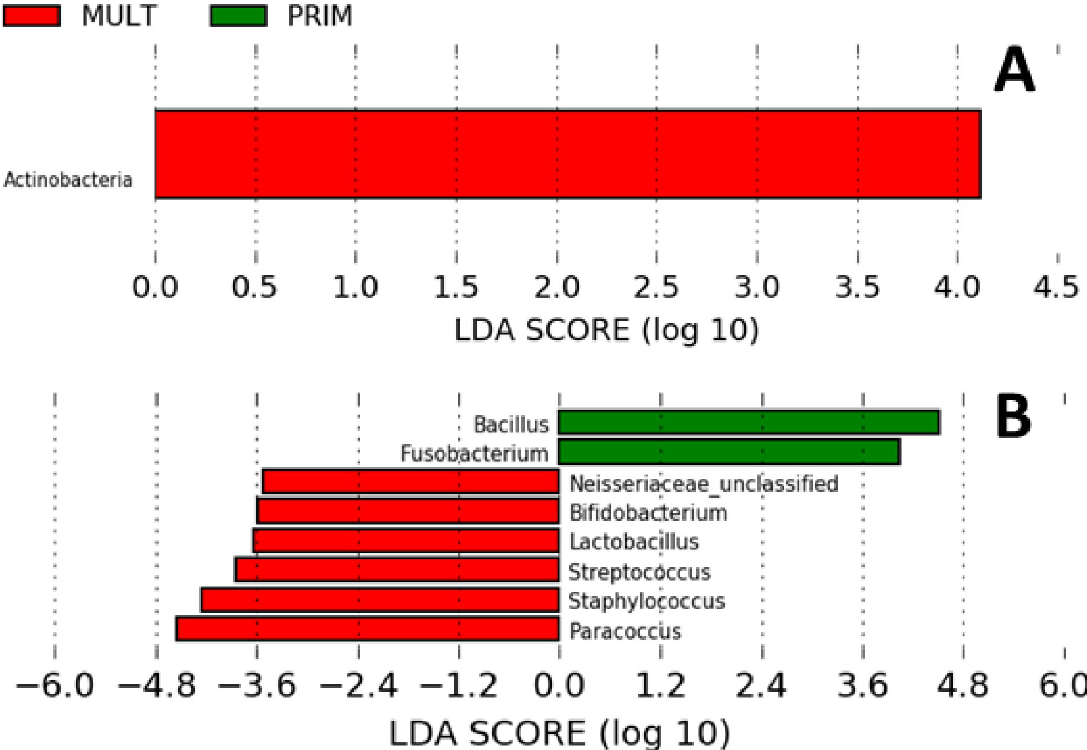
Fig 6. Linear discriminant analysis (LDA) effect size plots showing the differences in uterine microbiota between primiparous (PRIM; n = 7) and multiparous (MULT; n = 9) cows in samples collected at 10, 21, and 35 d in milk (DIM). Histograms show the LDA effect size computed for features at the phyla (A) and genera (B) levels. Enriched features for PRIM are indicated with positive LDA scores (green), and enriched features in MULT cows are indicated with negative LDA scores (red). Only features with P > 0.05 and an effect size cut-off of 3.5 are